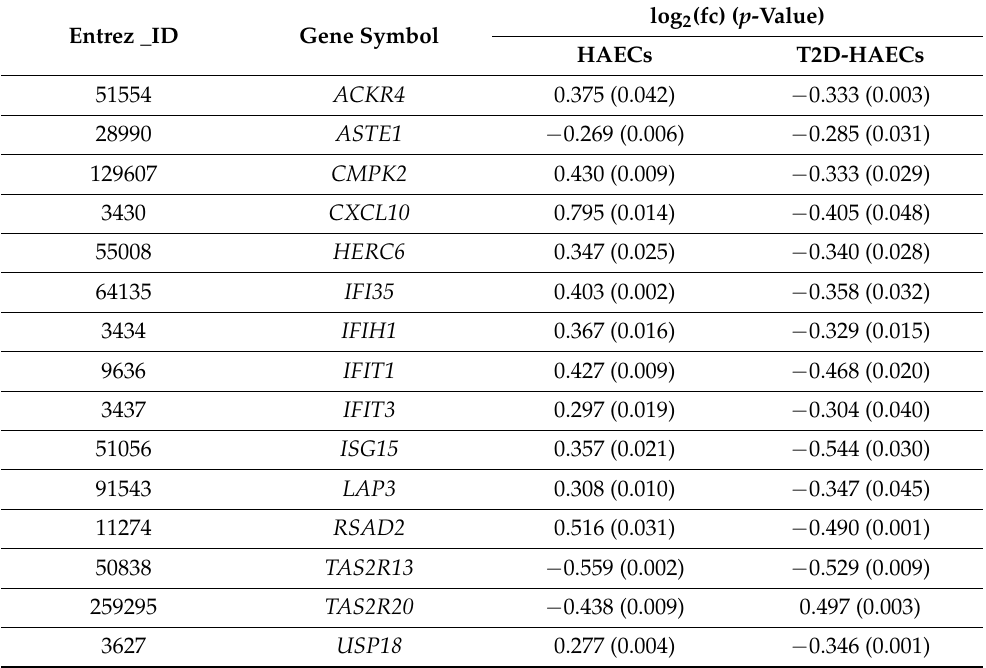
Table 3. List of changes in gene expression in HAECs and T2D-HAECs after exposure to 100 mGy radiation. Entrez _ID Gene Symbol